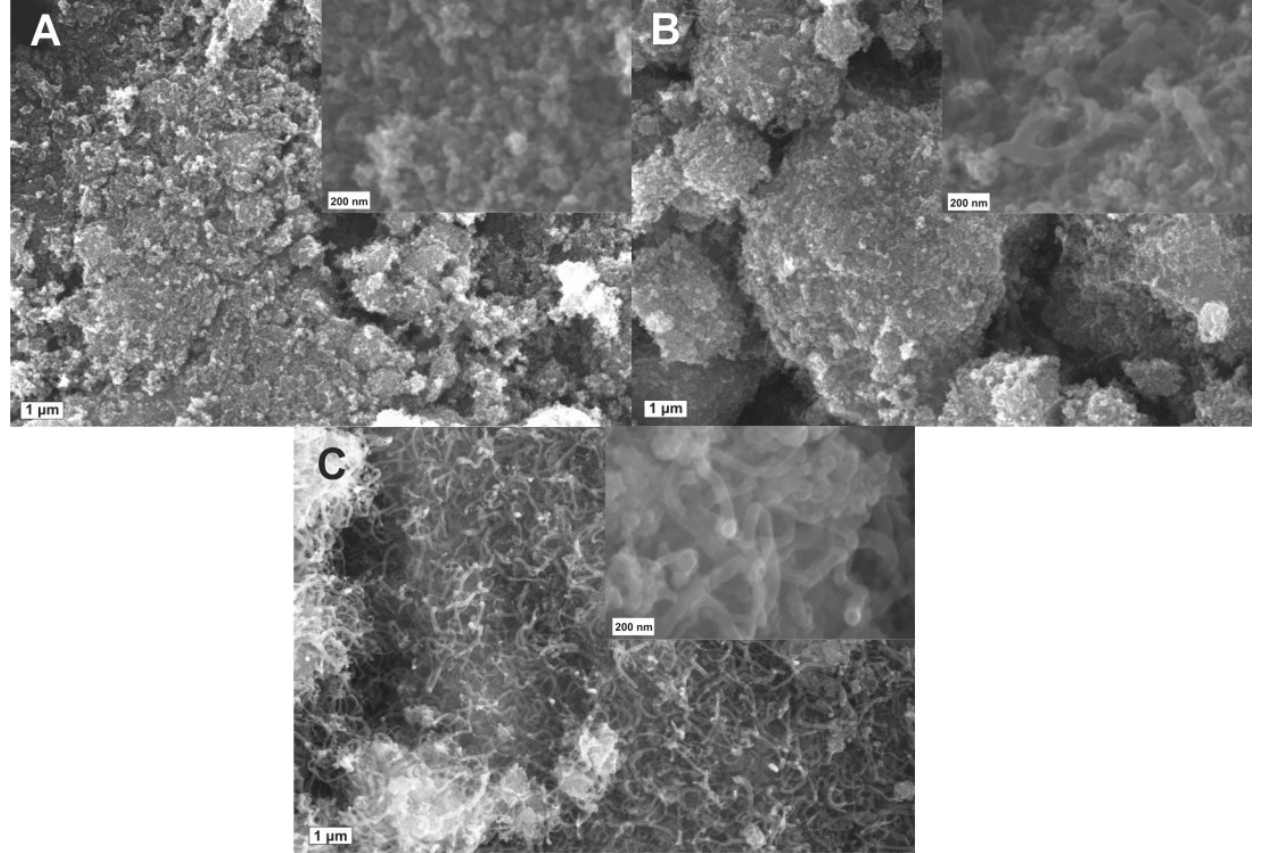
Figure 3. SEM images for CNT-TiO 2−δ composites with a growth time of 5 min ( A ), 15 min ( B ) and 60 min ( C ). The inserted images were taken at a higher